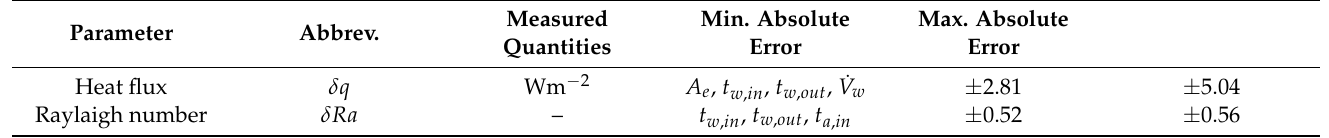
Table 5. Absolute errors of the calculated parameters for heat exchanger No.